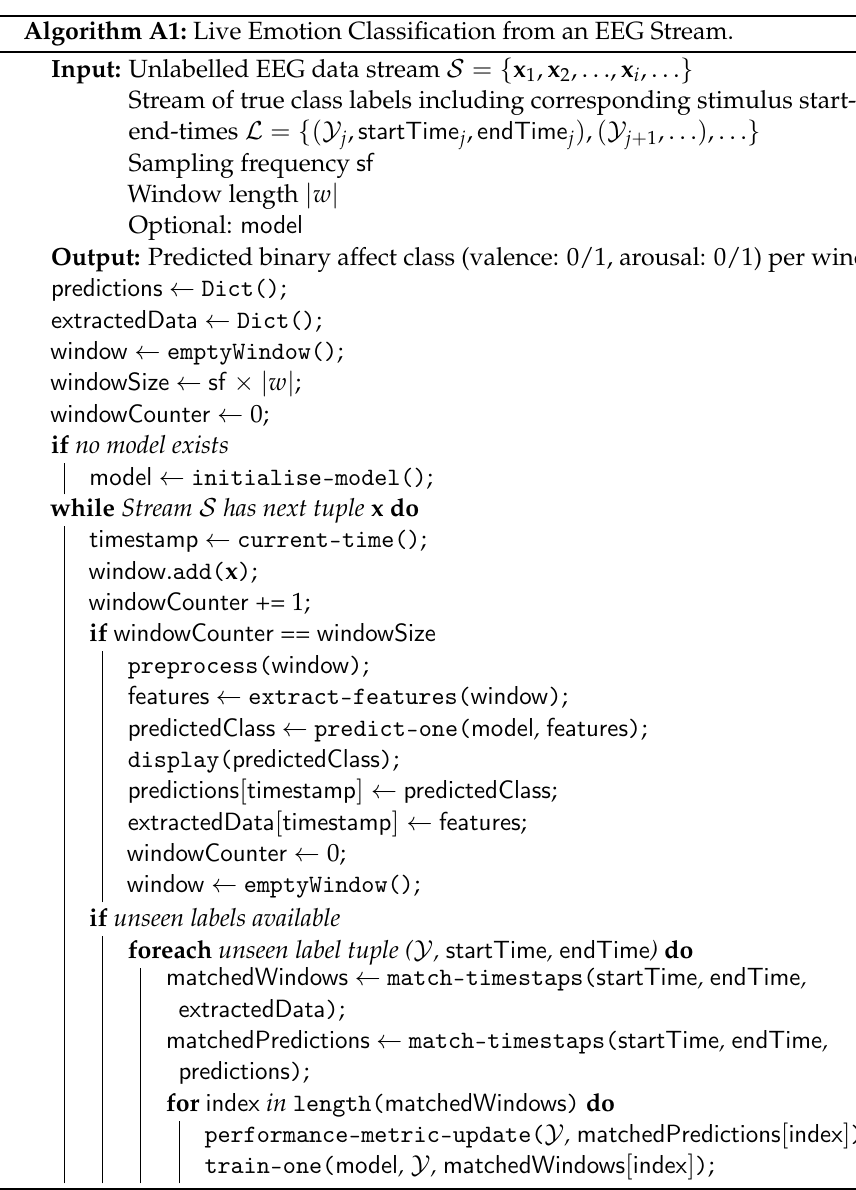
Algorithm A1: Live Emotion Classification from an EEG